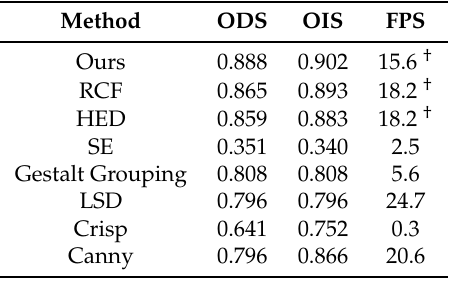
Table 4. The quantitative comparison with baselines on PLDM dataset, † means GPU